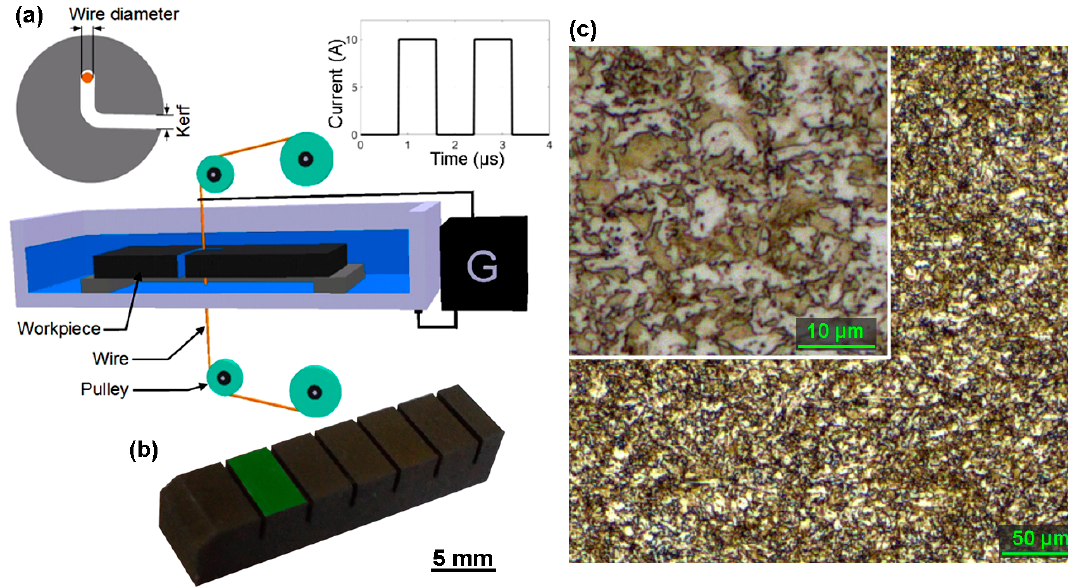
Figure 1. ( a ) Scheme of WEDM (wire electrical discharge machining); ( b ) produced samples-one sample labeled green; ( c ) microstructure of Creusabro 4800. labeled green; ( c ) microstructure of Creusabro